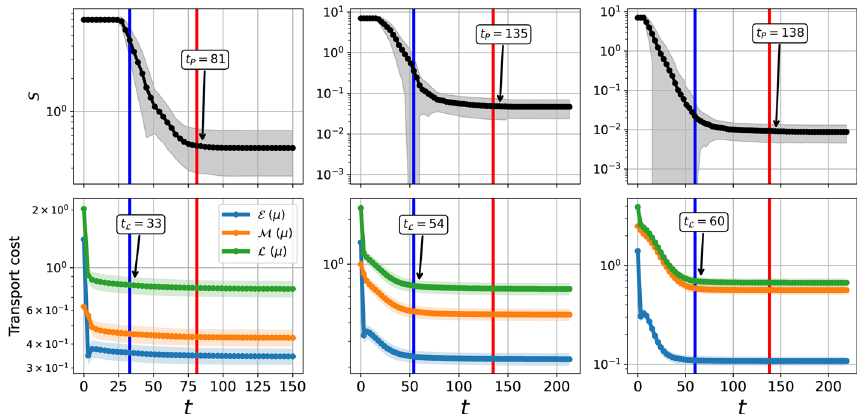
Fig. 5 Covered area and Lyapunov cost. Mean (markers) and standard deviations (shades around the markers) of the covered area S (top plots) and of the Lyapunov cost, energy dissipation E and structural cost M (bottom plots), as functions of time t . Means and standard deviations are computed on the set described in Paragraph Synthetic OT problems . From left to right: β = 1.2,1.5 and 1.8. Red and blue lines denote t P and t